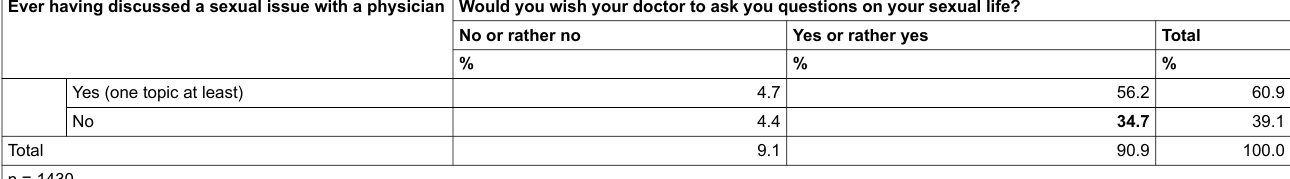
Table 2: Concordance between patients’ wishes about discussion on sexual topics and patients’ experience of discussing on at least one sexual topic with a